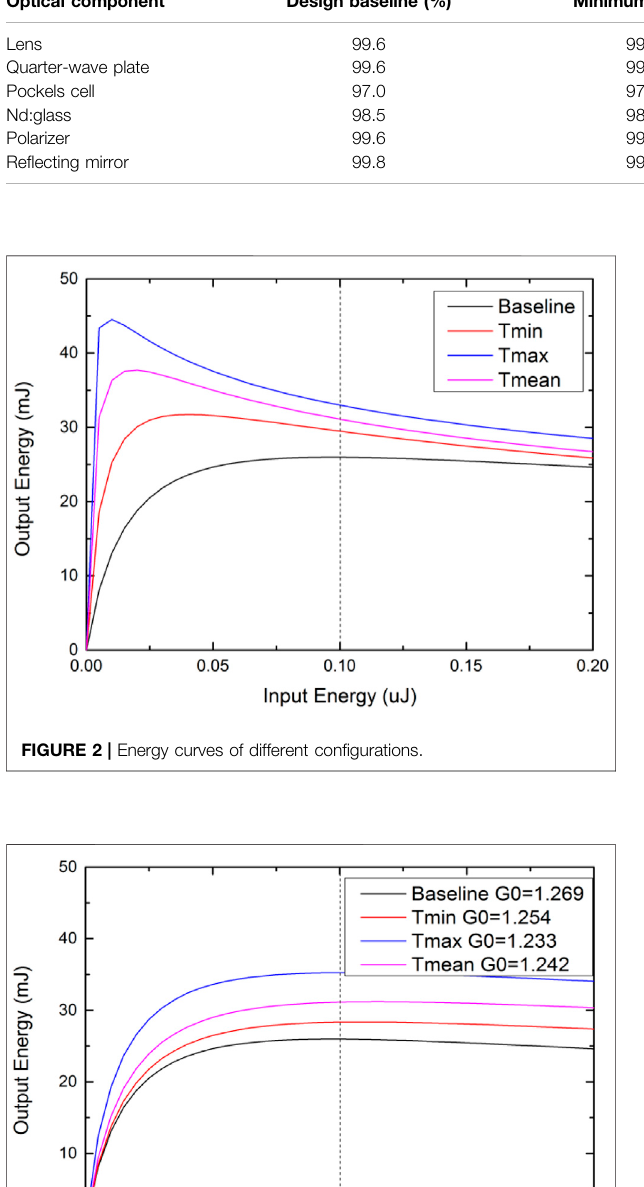
TABLE 1 | Typical parameters of optical components. Optical component